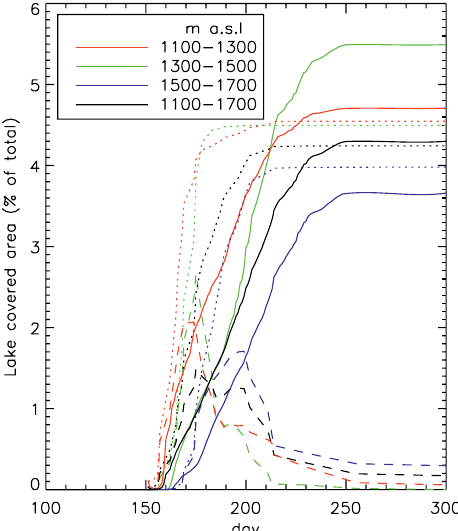
Fig. 5. Comparison between modelled (solid), observed (dashed) and cumulative observed (dotted) fractional lake area in 2003 for three altitude bands in the Russell glacier catchment of the Green- land Ice